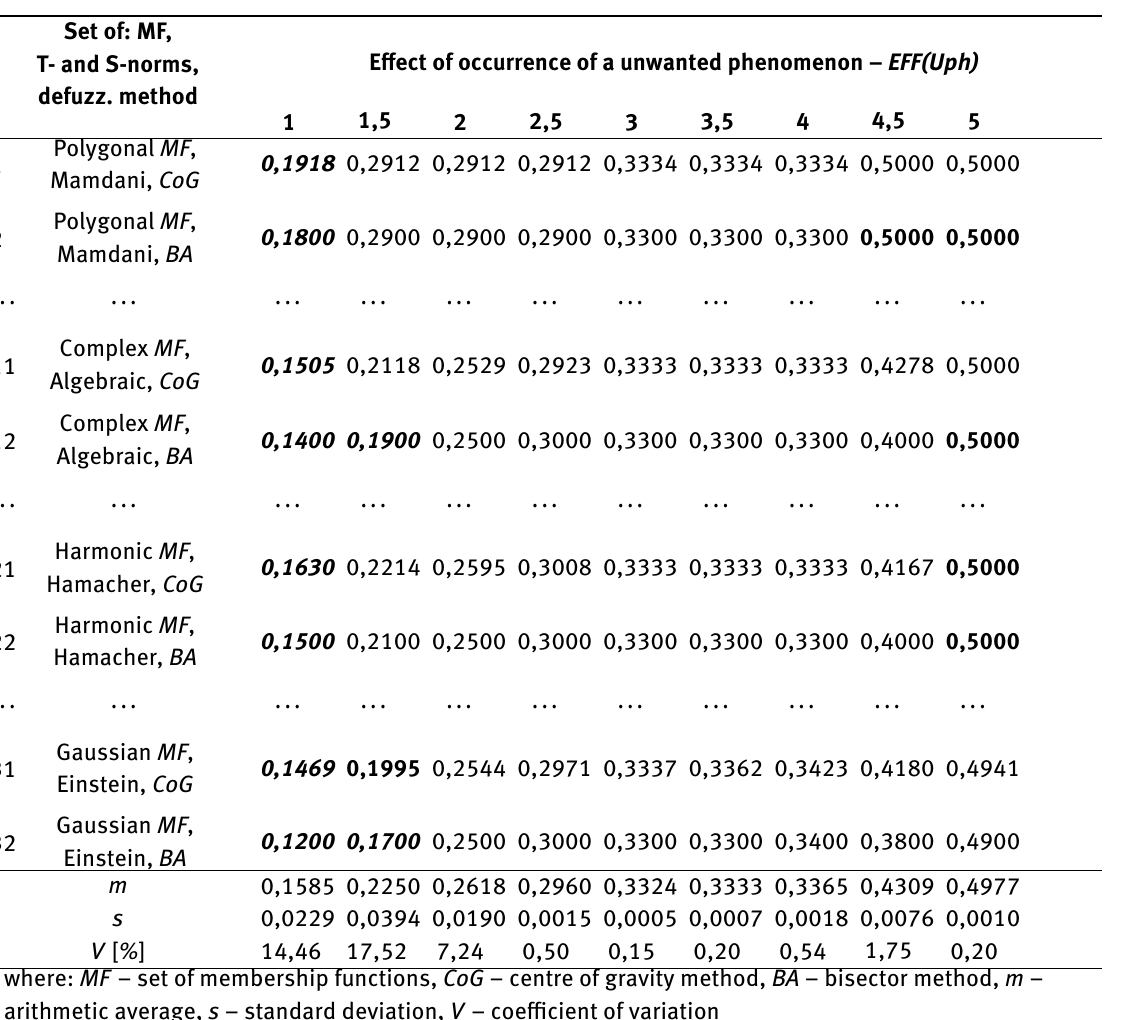
Table 3: Values of the output variable y for different variants of membership functions – part of the analyzed values of the input variables in section x 1 = 0,2 Set of: MF, T- and